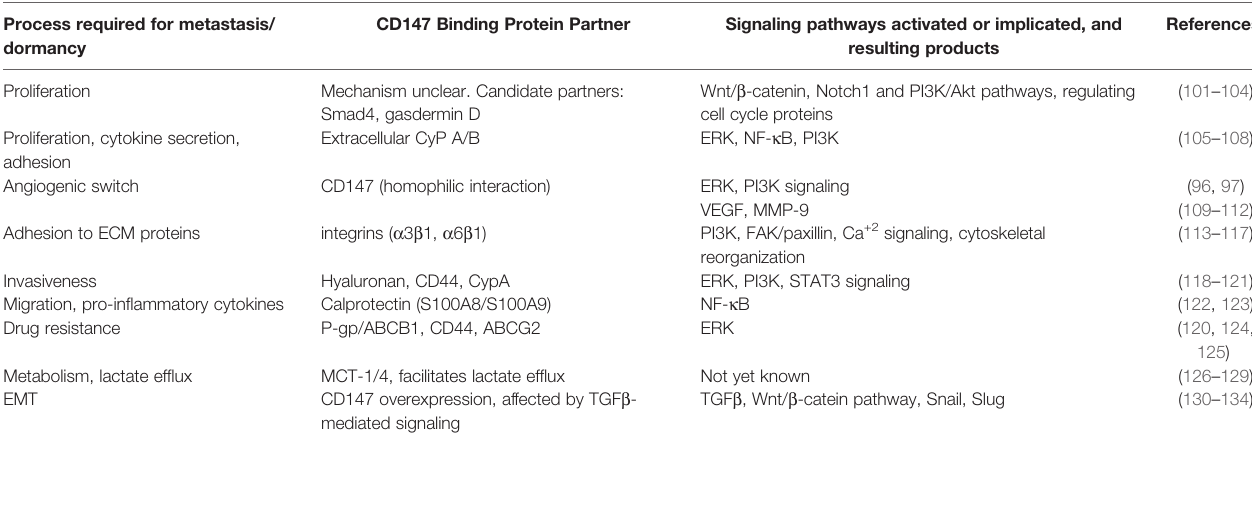
TABLE 1 | The multifunctional CD147 protein acts as a hub protein that binds many protein partners, thus promoting processes that could lead to escape from dormancy. Process required for metastasis/ CD147 Binding Protein dormancy